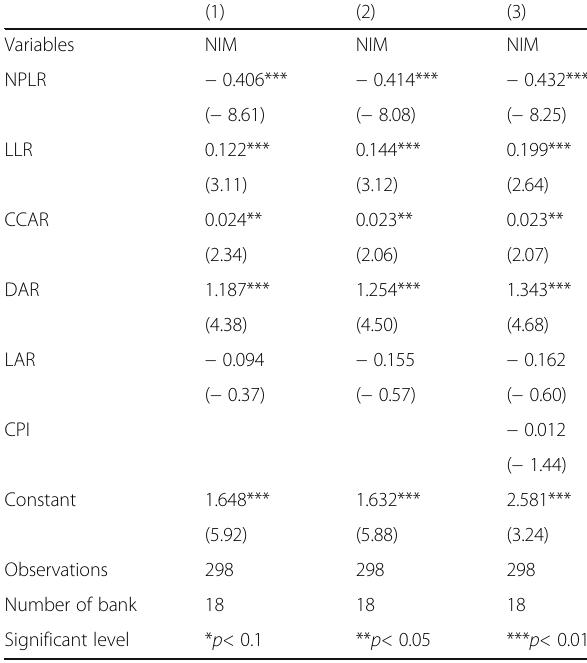
Table 1 Stata random effect regression